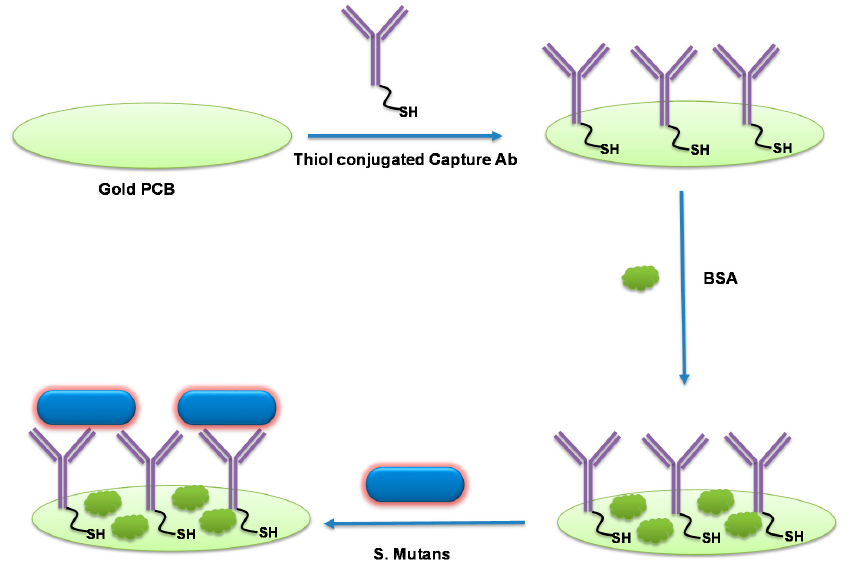
Figure 1. Schematic illustration of the label-free electrochemical S. Mutans detection scheme.